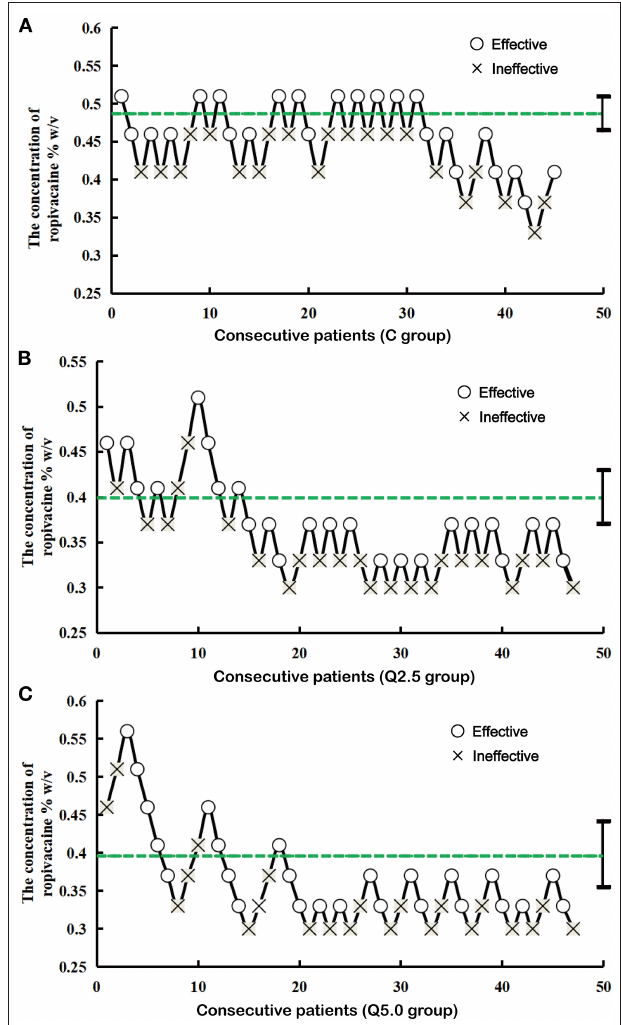
FIGURE 3 | Consecutive ropivacaine concentration during great saphenous vein surgery for determining EC 50 . The lines represent the mean ropivacaine (%, w/v) concentration when crossing from a failure to inhibit analgesia. The average of these concentrations is defined as the EC 50 . The EC 50 of ropivacaine was 0.487% with a 95% CI of 0.510–0.465% in the C group (A) , 0.399% with a 95% CI of 0.371–0.430% in the Q2.5 group (B) , and 0.396% with a 95% CI of 0.355–0.441% in the Q5.0 group (C) .